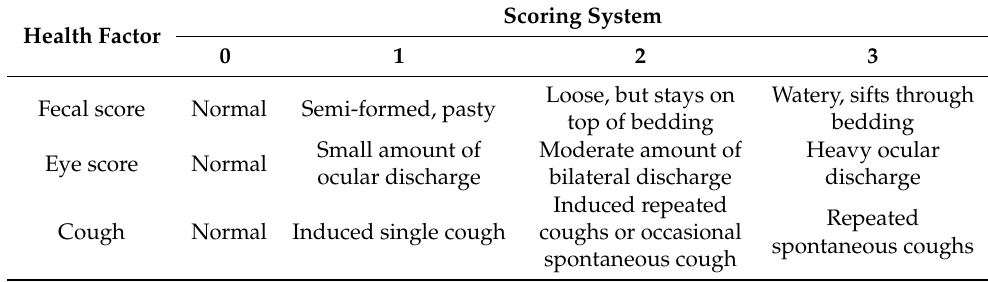
Table 1. Calf health factor scoring